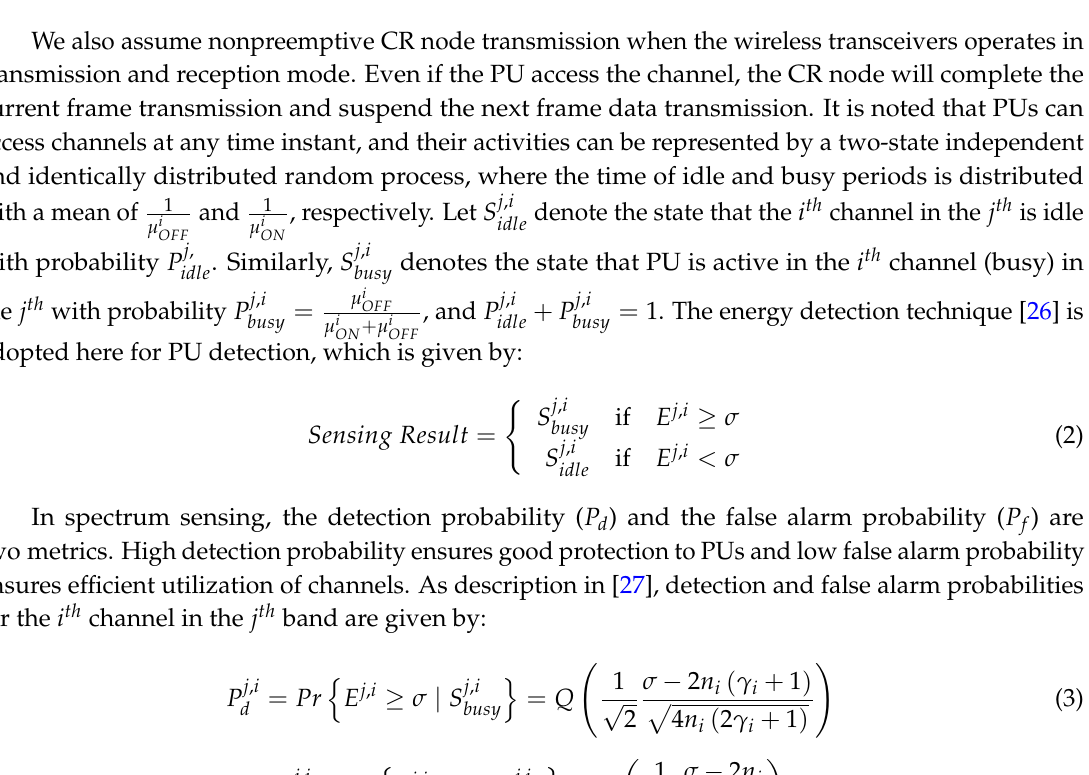
Figure 2. The schematic of FA-OFDM based PHY